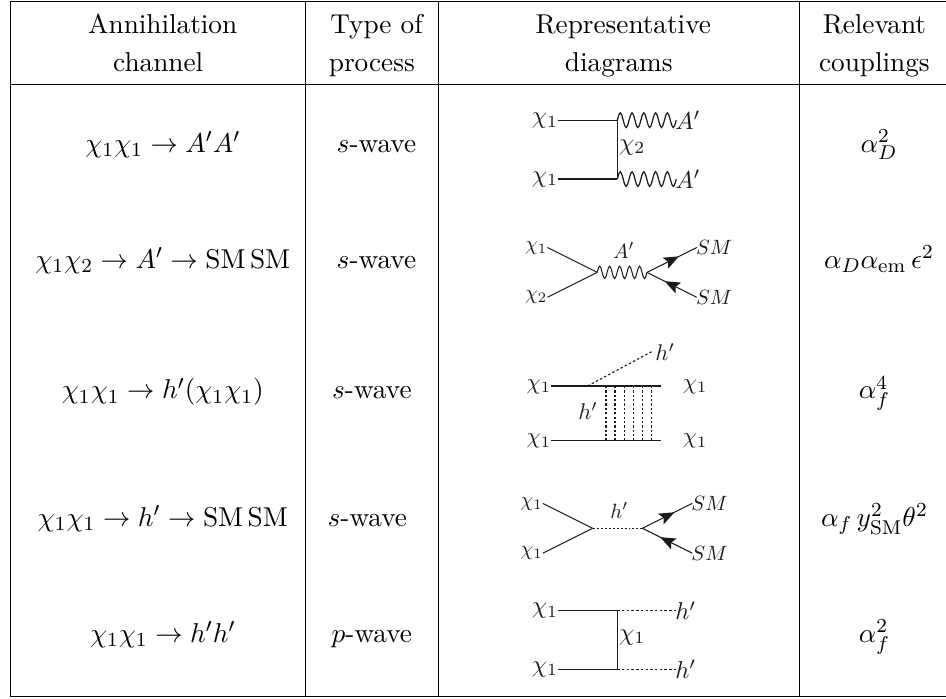
is the fine-structure constant and y em